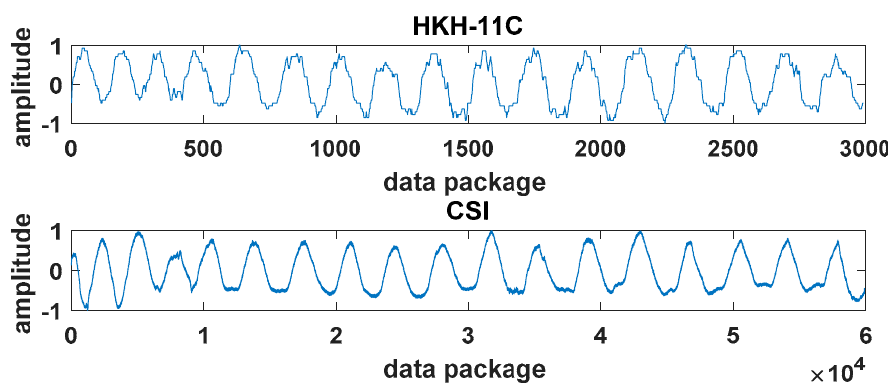
Figure 12. Comparison between CSI data and HKH-11C data.